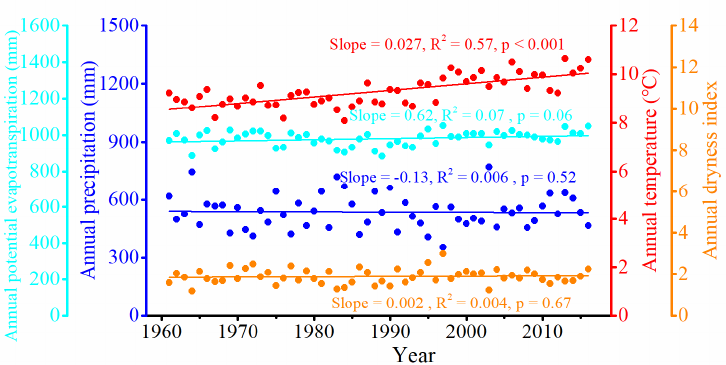
Figure 3. Temporal variations of annual precipitation, temperature, potential evapotranspiration, and the dryness index over the Weihe River basin during 1961–2016.